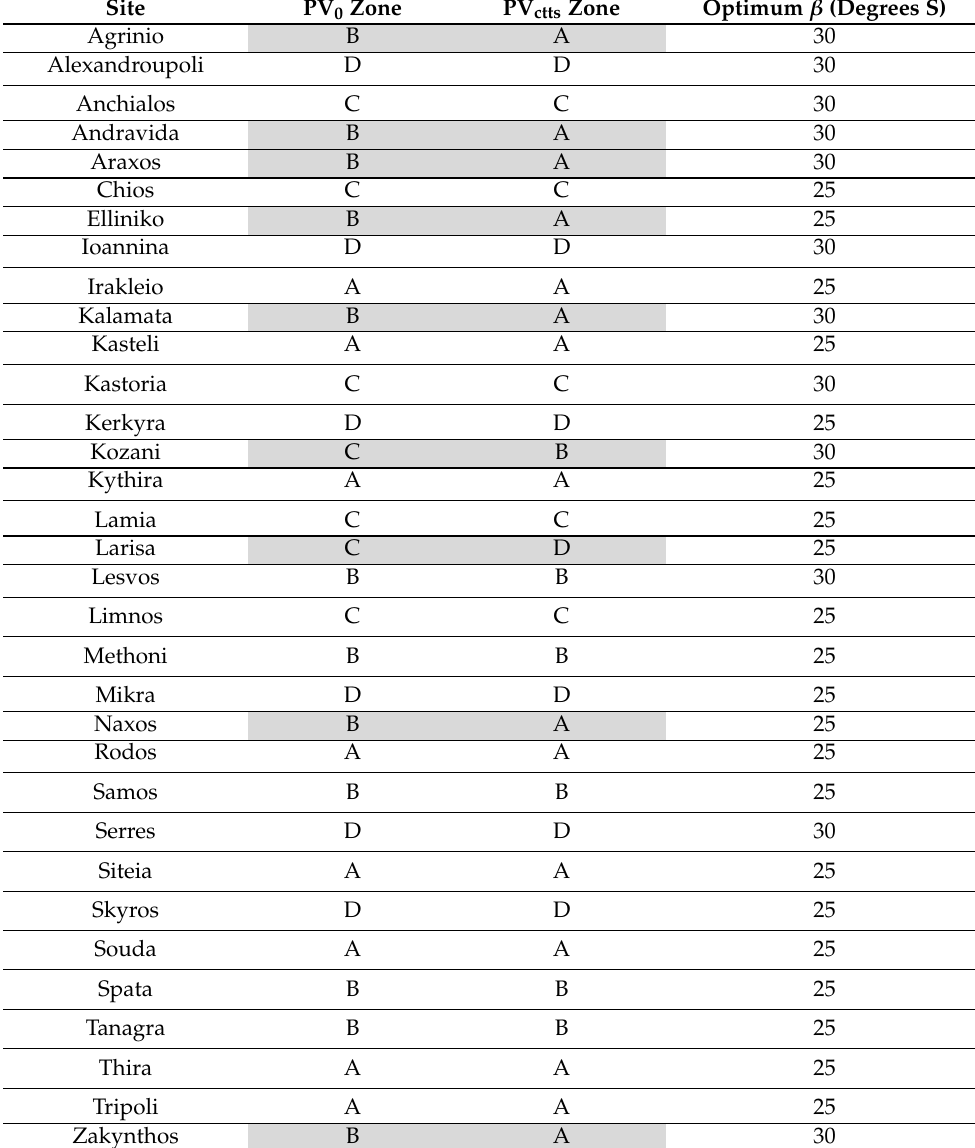
Table 5. Classification of the 33 sites in terms of the PV 0 and PV ctts zones, together with the optimum inclination angle β to the south of the solar flat-plane convertors operating in Greece for a whole year. It is worth observing that only one-third of the sites utilize β = 30 ◦ . The gray rows denote a change of the site’s categorization from the PV 0 zone in Table 3 (see also Figure 3b) to the PV ctts scheme in Figure